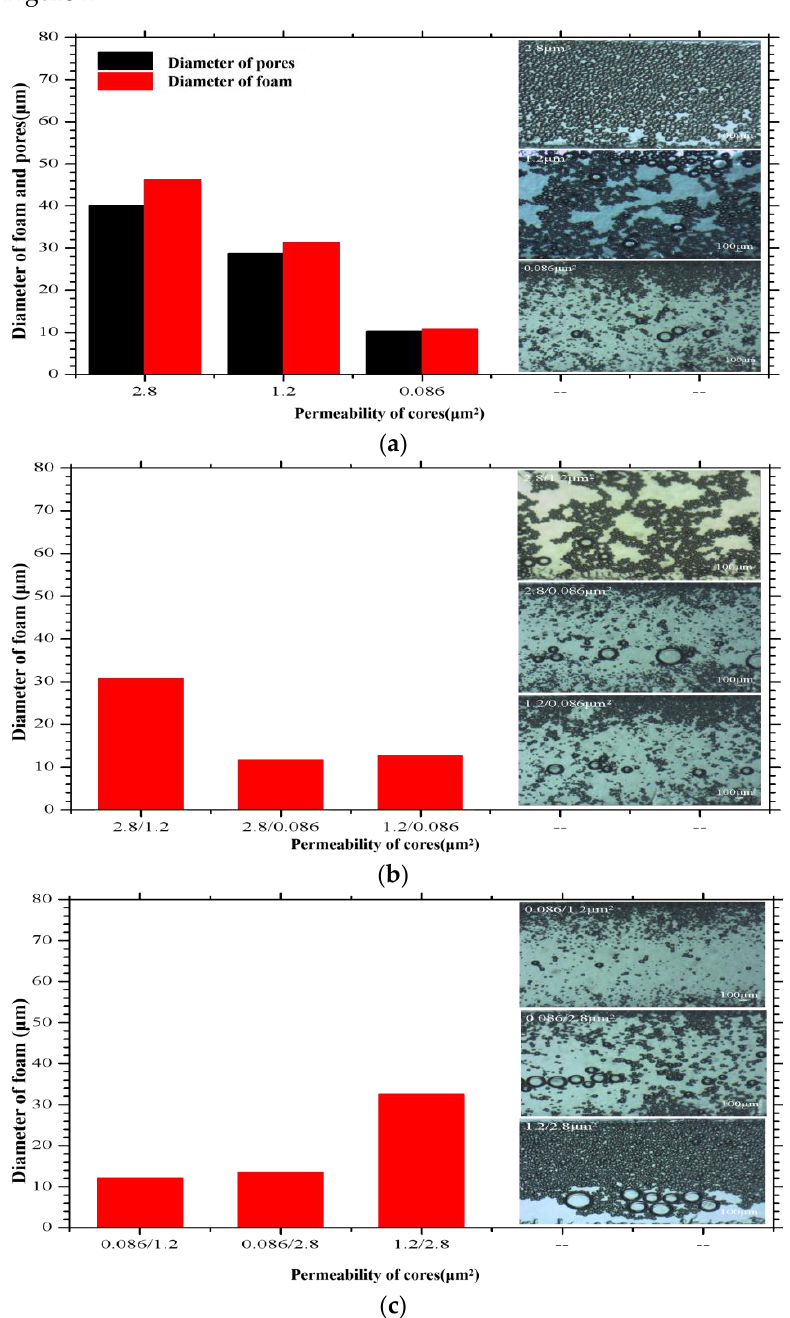
Figure 2. Particle size adaptation characteristics of foam in porous media. (Note: ( a ) shows the diameters of bubbles and the diameter of pores versus permeability. ( b ) shows the relationship between the diameters of the bubbles from the high permeability layer to the low permeability layer bubbles. ( c ) shows the relationship between the diameters of bubbles from the low permeability layer to the high permeability